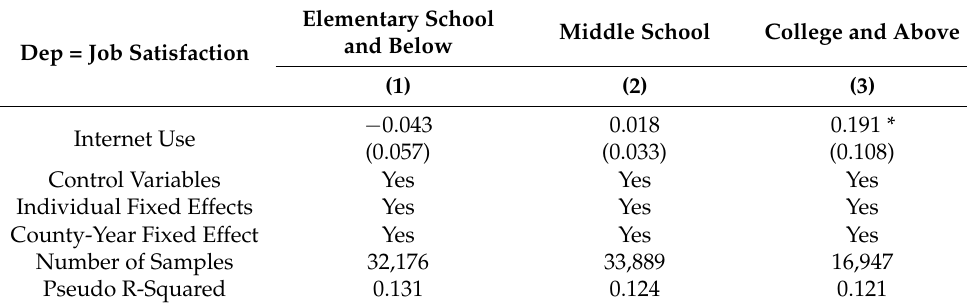
Table 5. Educational Attainment